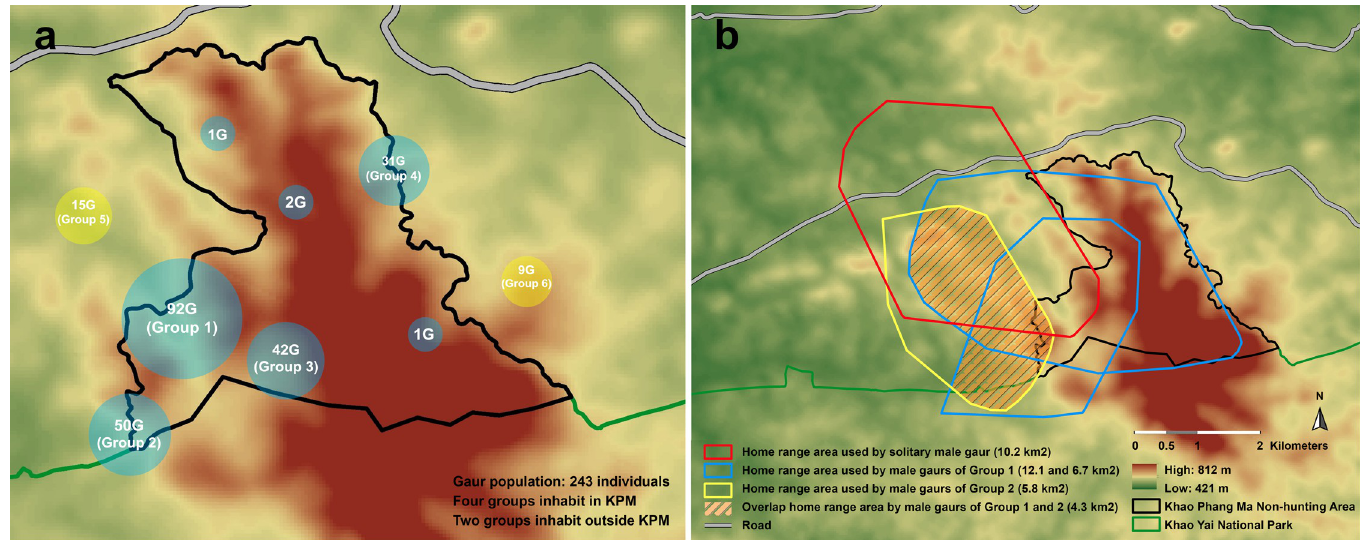
Fig 1. Global positioning system (GPS) tracks. Thirteen wild gaurs in Khao Phaeng Ma (KPM) Non-Hunting Area, Thailand, 2021. (a) The gaur population group in KPM is divided into six subpopulations (Groups 1–6): a blue circle represents the groups dwelling in KPM, and a yellow circle represents the groups living outside the protected area; “xxxG” indicates the number of gaurs in each herd, (b) The overall home range area of male gaurs (Group 1 and Group 2), and their area of overlap in protected areas and agricultural areas.